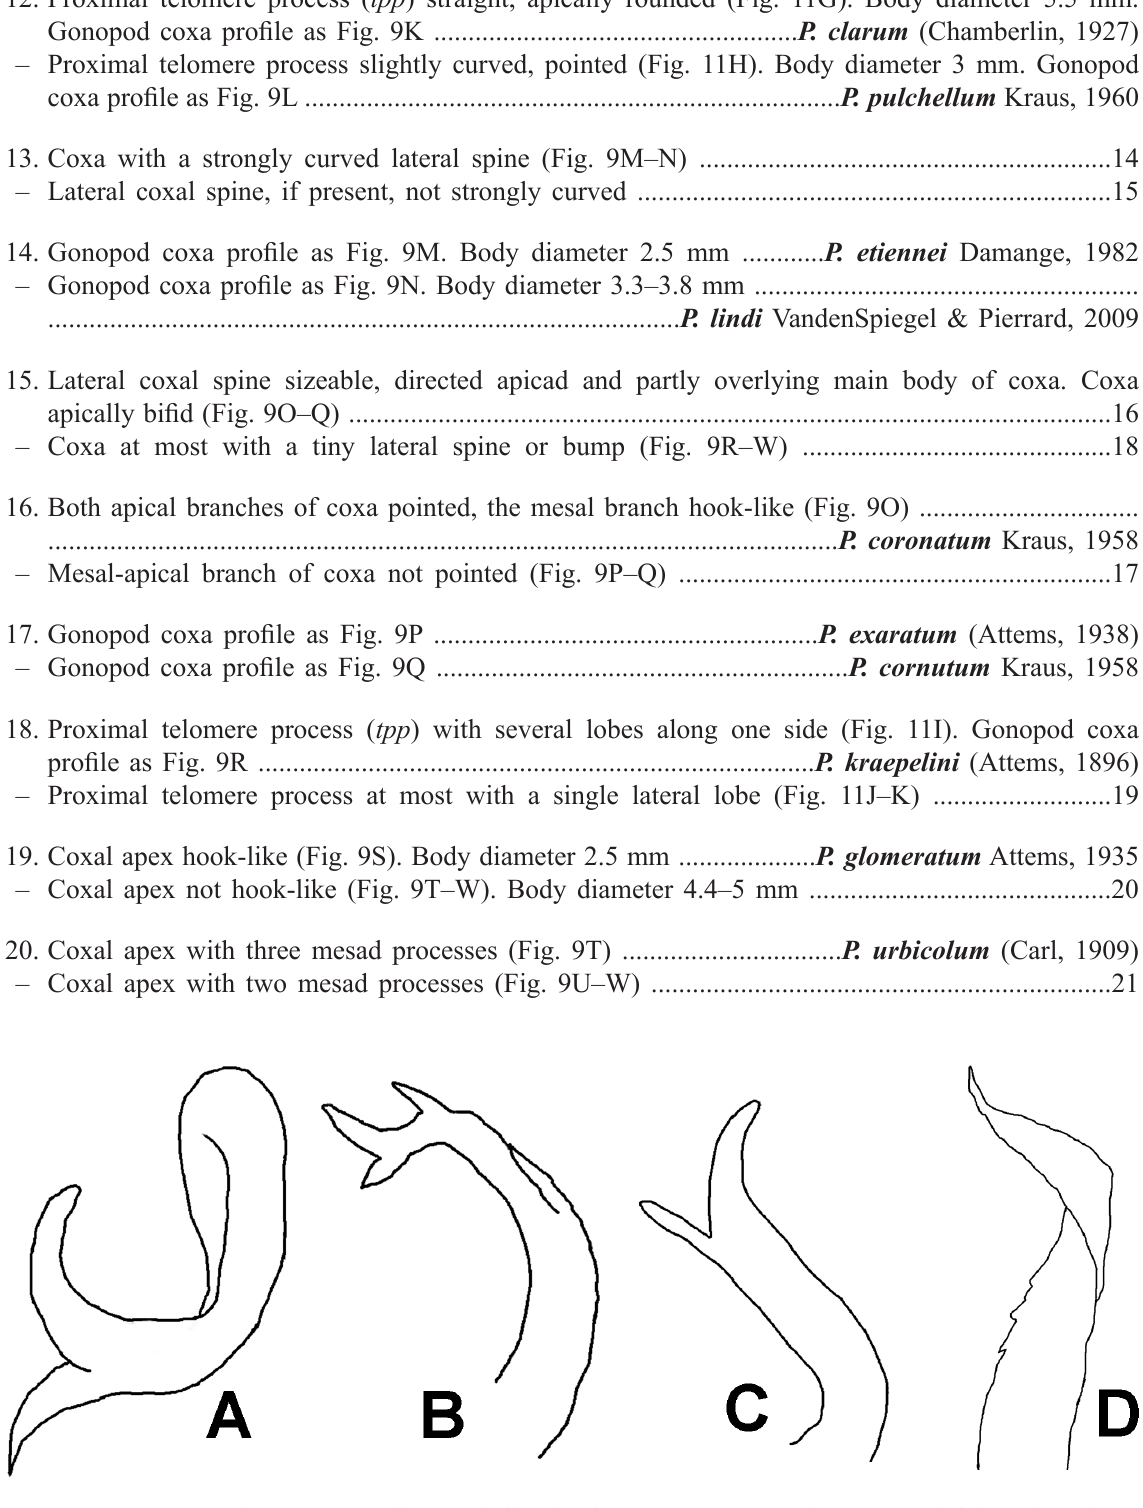
Fig. 10. Prionopetalum spp., outlines of distal telomere process ( tdp ). A . P. bifidum (based on VandenSpiegel & Pierrard 2009). B . P. tricuspis (based on VandenSpiegel & Pierrard 2009). C . P. aculeatum (based on Attems 1914). D . P. asperginis sp. nov. (orig.). Not to